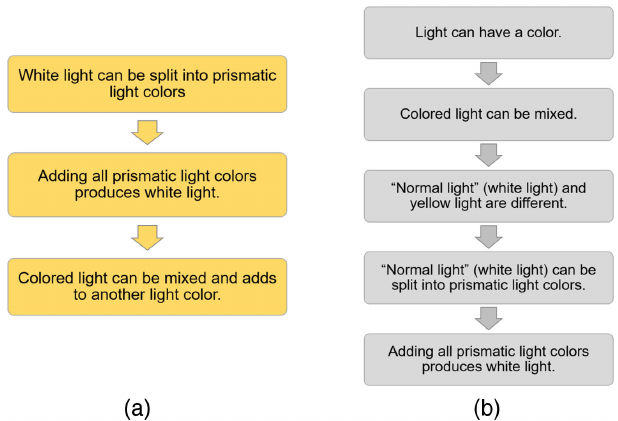
FIG. 12. Spectral composition of light: (a) traditional content structure and (b) new content